Question: Sum up the contents of this chart in one sentence.
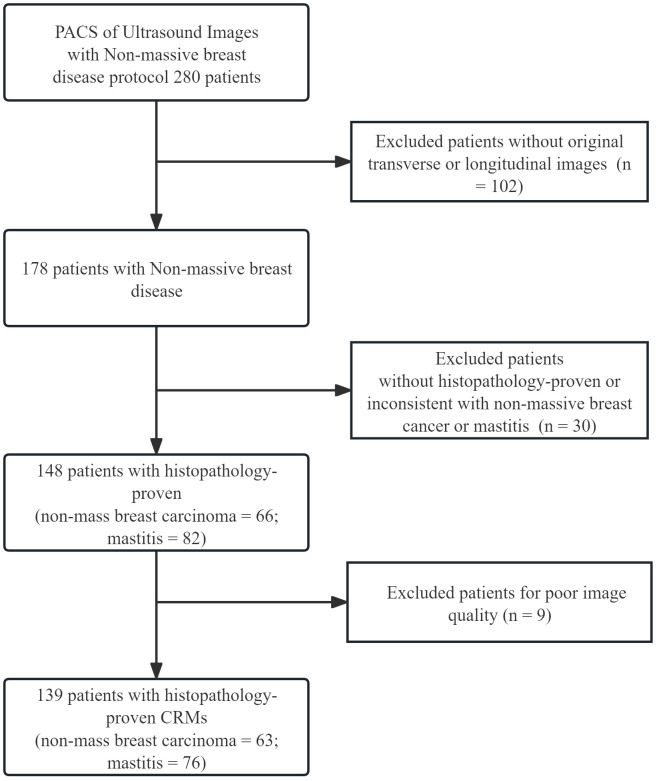
Answer: Patient distribution and definition of the training and validation datasets.